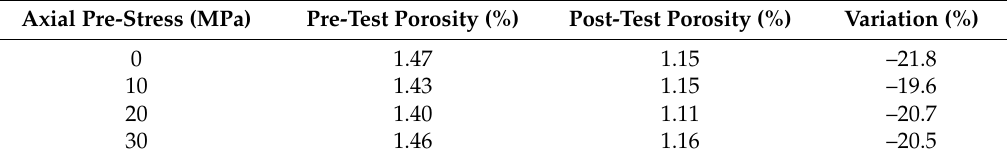
Table 3. The porosity variation before and after the